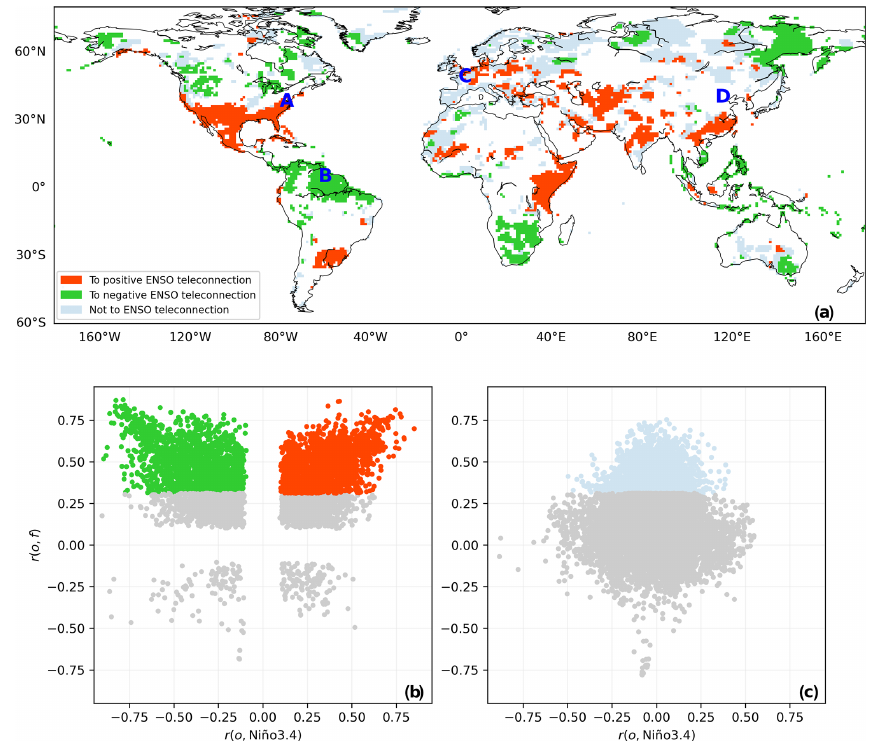
Figure 6. (a) Spatial distribution of grid cells for the three cases attributing anomaly correlation of CFSv2 forecasts to ENSO teleconnection. Scatter plots of anomaly correlation against ENSO teleconnection for grid cells (b) with significant overlapping R 2 and (c) without significant overlapping R 2 . Grey points in panels (b) and (c) are marked in white in panel (a) . Four grid cells are selected and labeled with capital letters from panel (a) for the subsequent analysis of the attribution of CFSv2 forecasts to ENSO teleconnection.